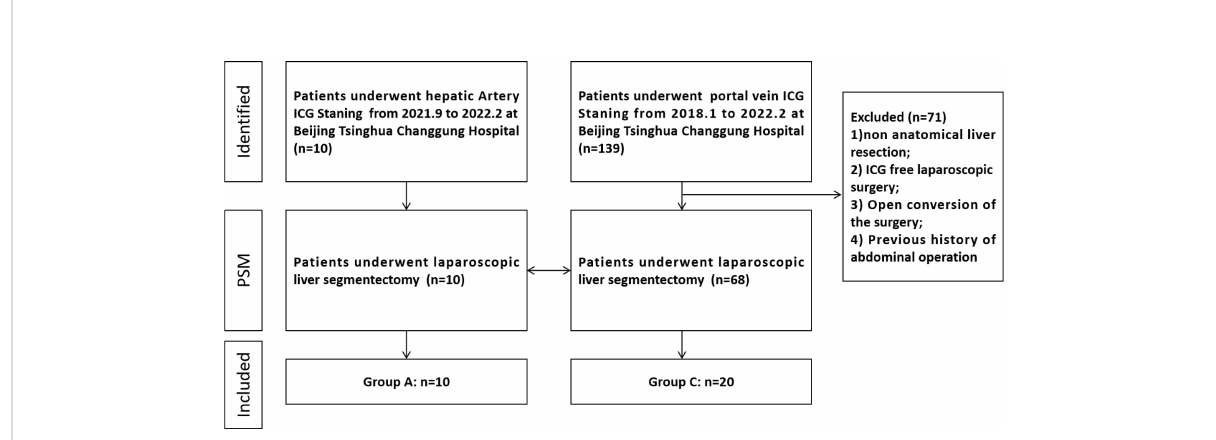
FIGURE 2 Protocol for patients who underwent liver watershed or segment